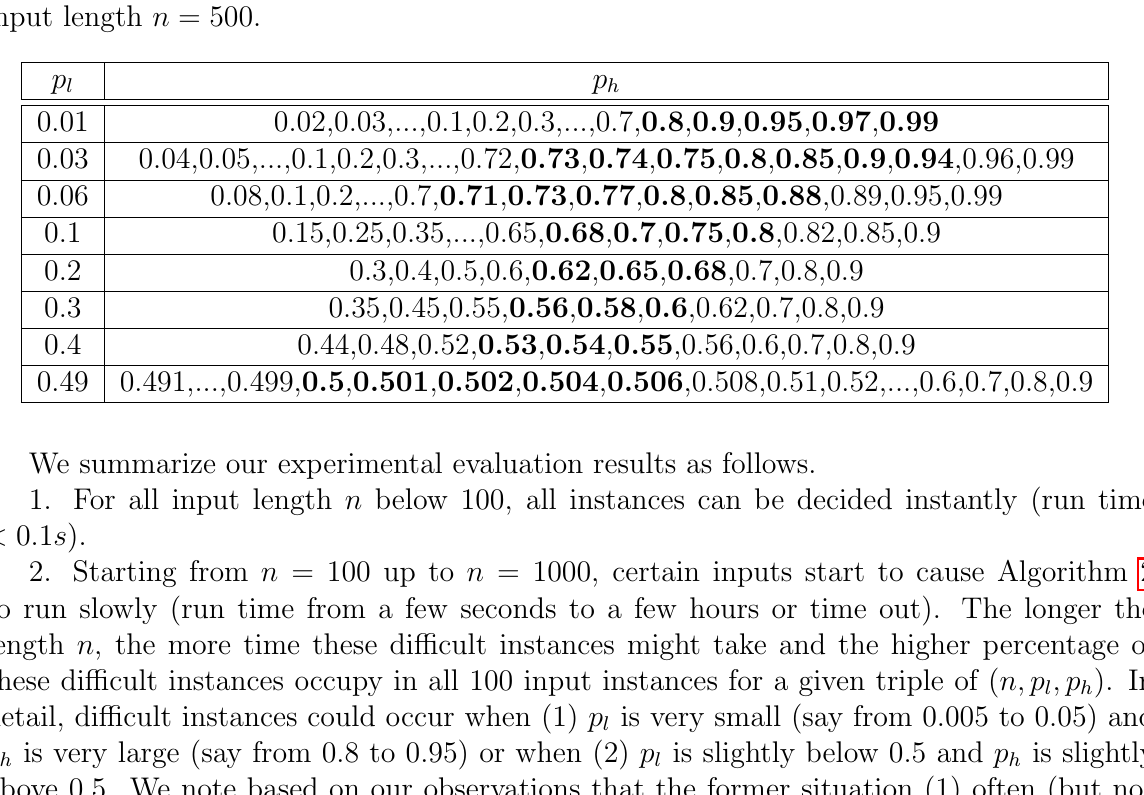
and p in the experimental performance evaluation of Algorithm 2 for l h